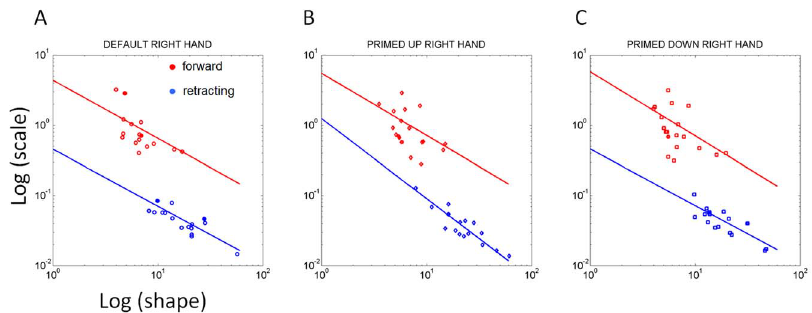
Figure 4. Individual stochastic signatures of variability for each patient separate the scatter in the Gamma plane representing the voluntary task-relevant (forward) and the spontaneous (retracting) task-incidental modes of acceleration control across all conditions. The cognitive load of the task systematically alters the slope of the retracting segments with spatial orientation priming.